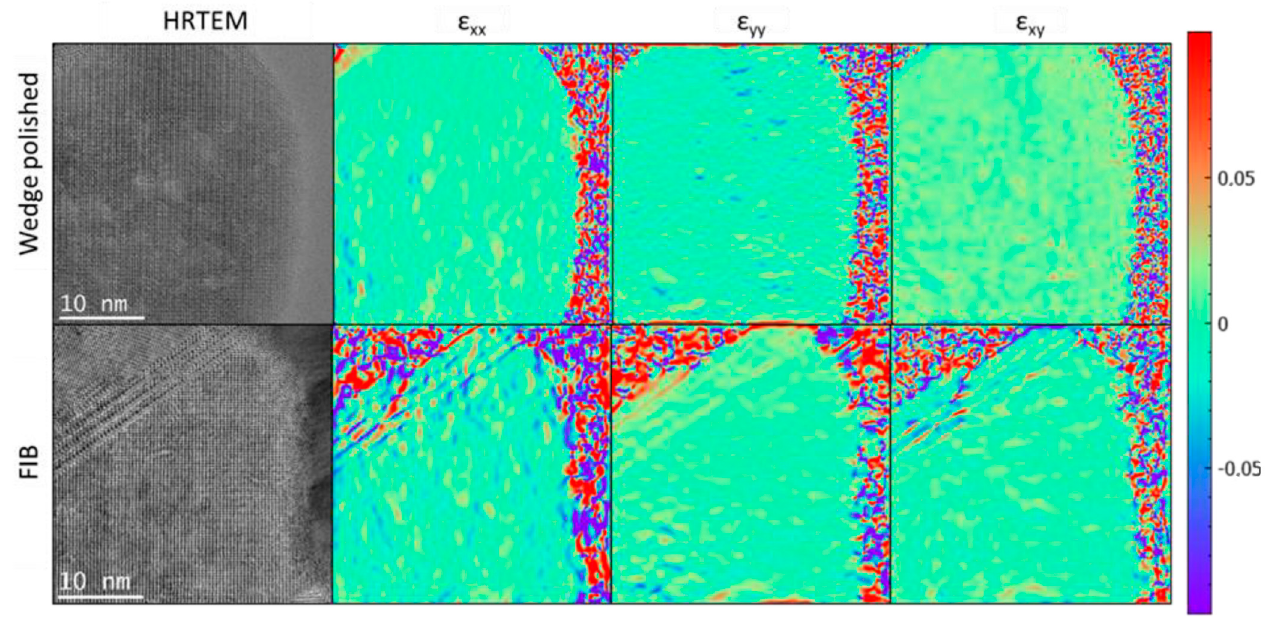
Figure 6. GPA strain profiles calculated from both samples on [110] zone axis orientation. The x axis corresponds to the [100] direction and the y axis to the [110] direction.